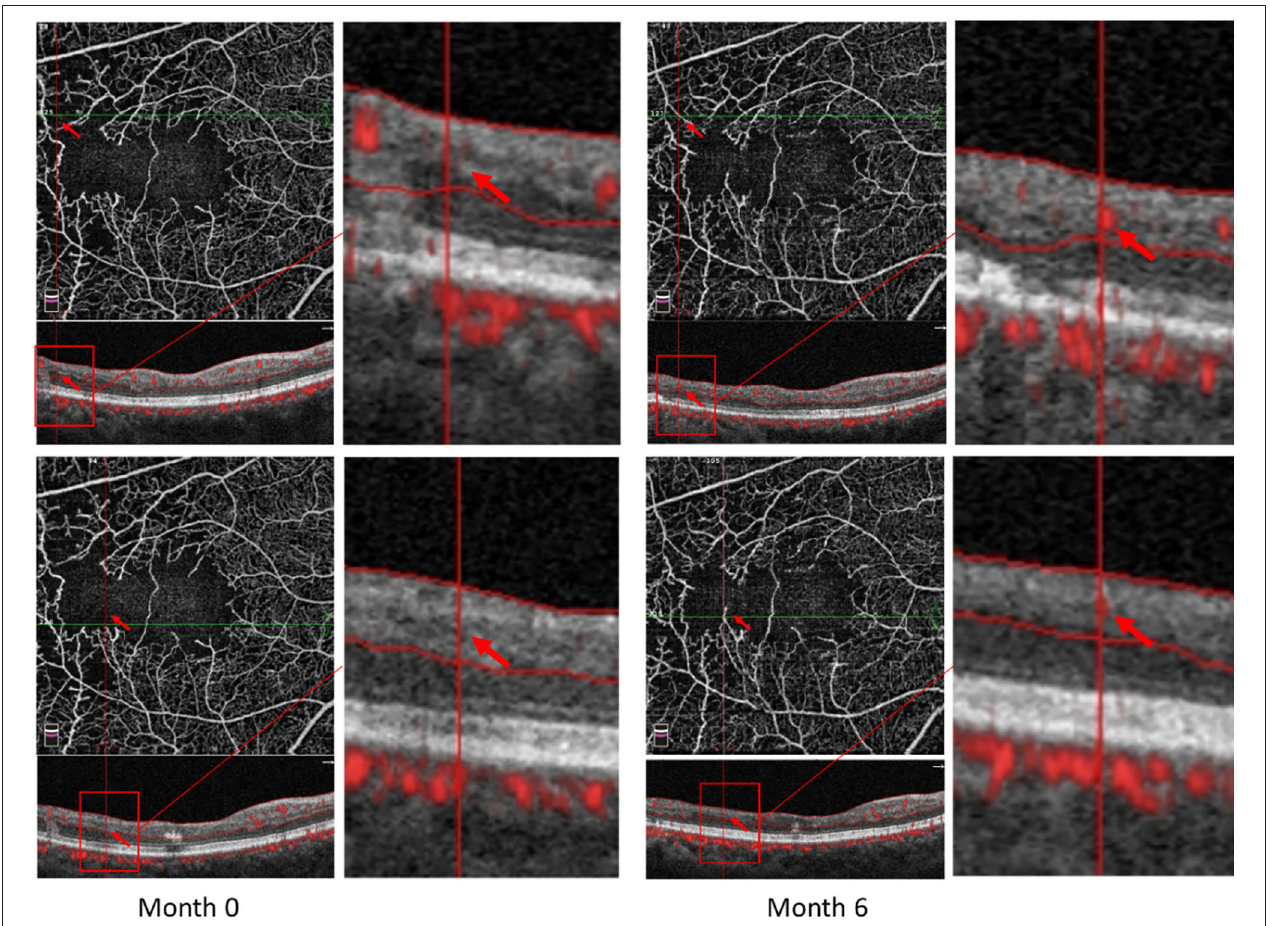
FIGURE 5 | Reperfusion occurred in the right eye of a 57-year-old female with macular ischemia after receiving anti-VEGF treatment. Red arrows indicate the growth of new capillaries and reperfusion in the macular nonperfusion